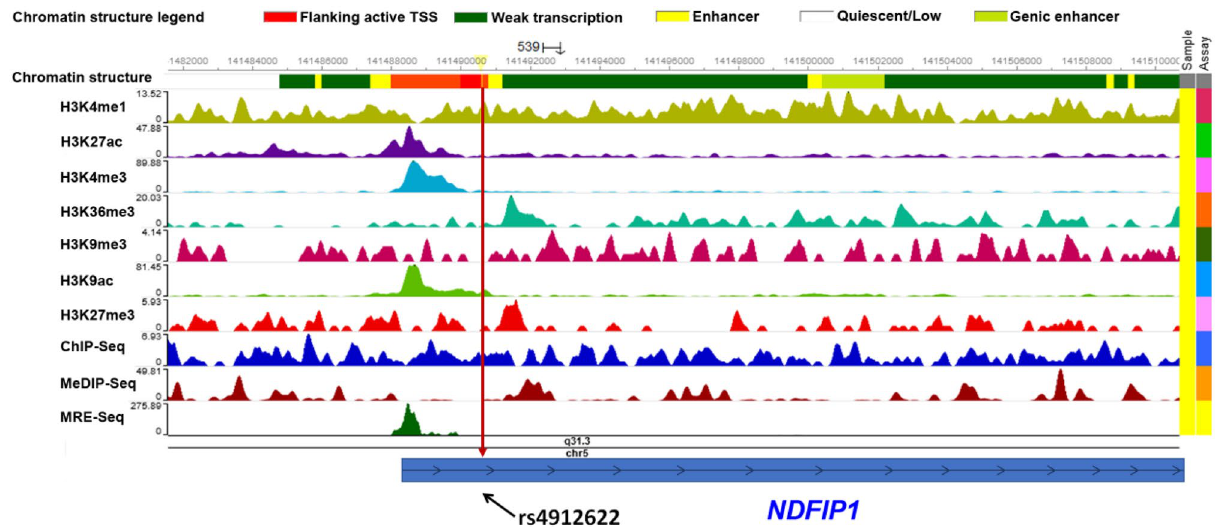
Figure 1. Roadmap epigenomics output for rs4912622. Chromatin structure and main epigenetic marks in the region surrounding rs4912622. Adapted from the Roadmap epigenomics project (http:// www. roadm apepi genom ics.